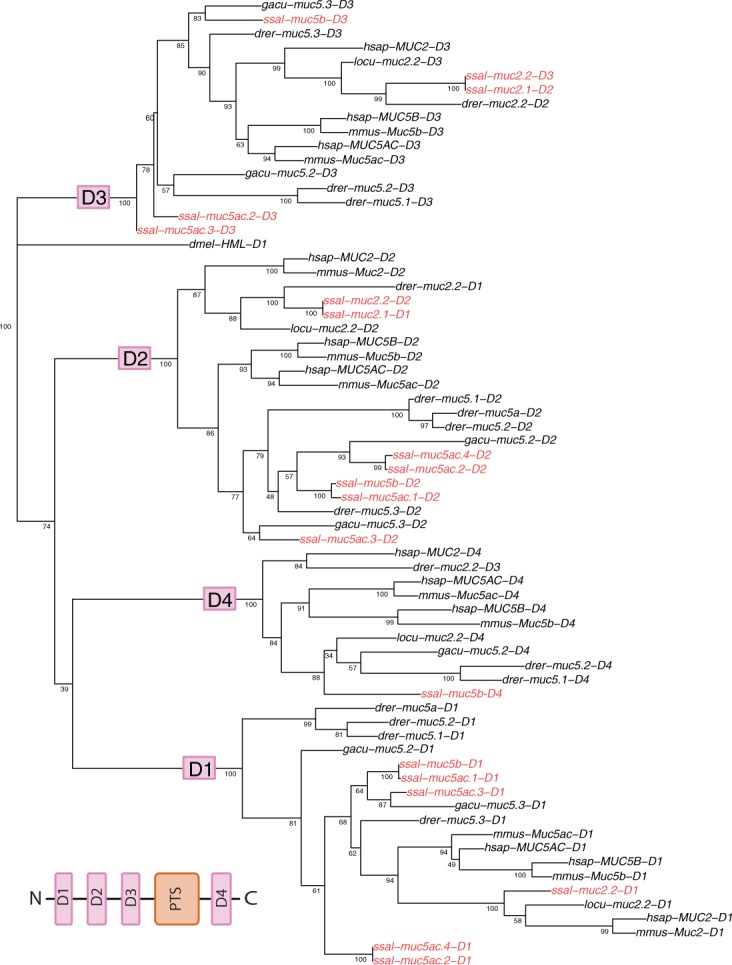
Phylogenetic tree of the identified Atlantic salmon mucins.The main branches represents clustering of the VWD domains, referred to as D1 to D4 based on their N-terminal position, as indicated in the insert figure. The Atlantic salmon (Salmo salar, ssal) VWD domains are highlighted in red, in total 19. In addition, VWD domains from several species are included in the tree, including stickleback (Gasterosteus aculeatus, gacu), spotted gar (Lepisosteus gacu, locu) zebrafish (Danio rerio, drer), mouse (Mus musculus, mmouse), human (Homo sapiens, hsap). The tree is rooted to the VWD domain found in Hemolectin of fruit fly (Drosophila melanogaster, dmel), a non-vertebrate mucin orthologue [21].